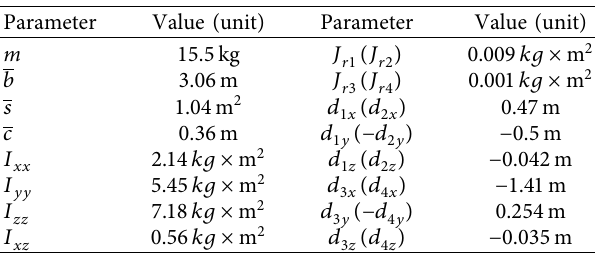
Figure 1: The structural platform of TRUAV. Table 1: UAV